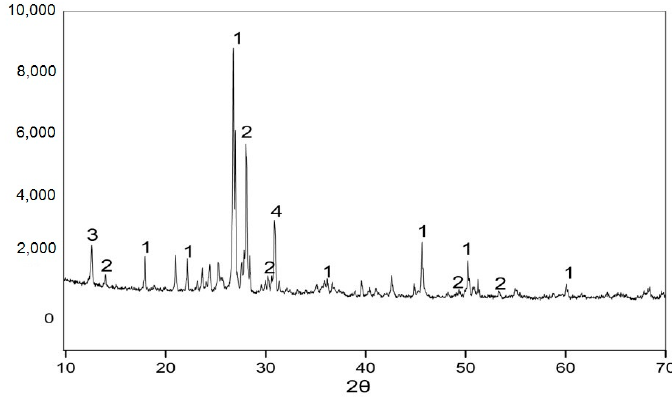
Figure 3. X-ray diffraction (XRD) pattern of raw copper-mine tailings’ powder (1 quartz, 2 albite, 3 chlorite, 4 dolomite).